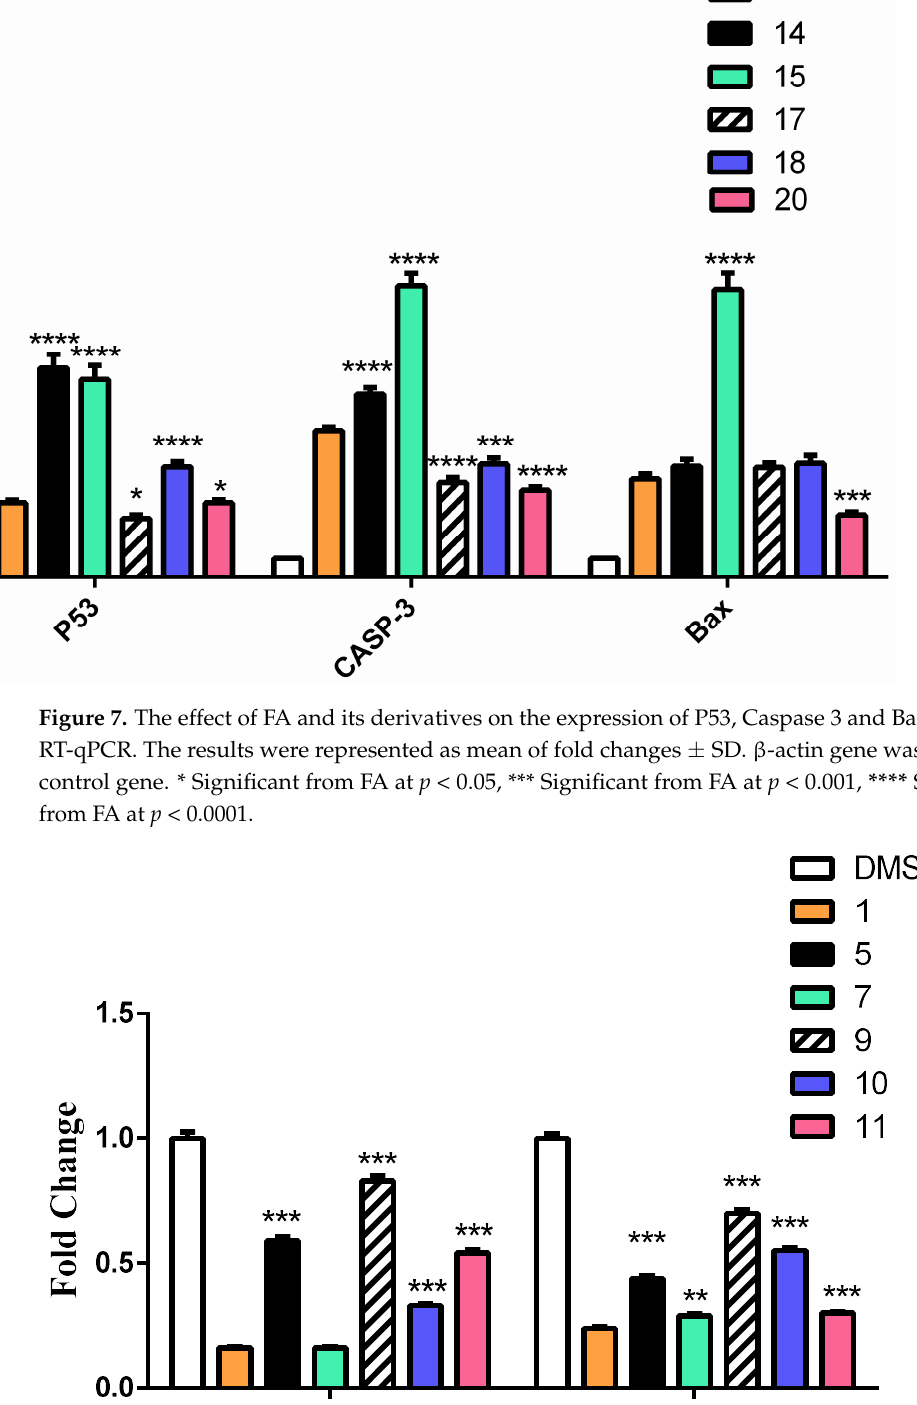
Figure 9. The effect of FA and its derivatives on the expression of MMP-2 and MMP-9 genes by RT- qPCR. The results were represented as mean of fold changes ± SD. β-actin gene was used as a control gene. *** Significant from FA at p < 0.001.